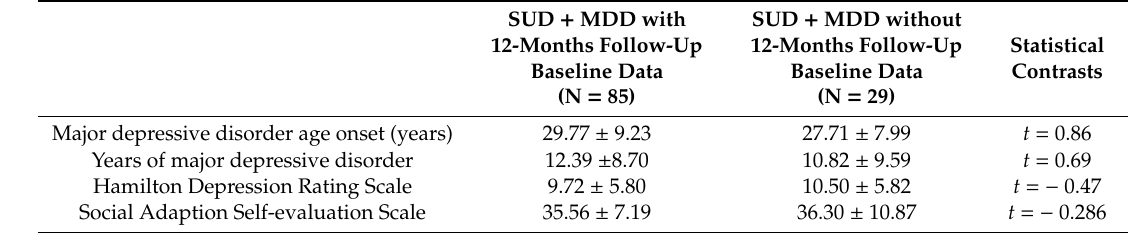
Table 7. Clinical measures (means and standard deviation) for de dual disorder group with Substance Use Disorder and Major Depressive Disorder with / without follow-up data at 12